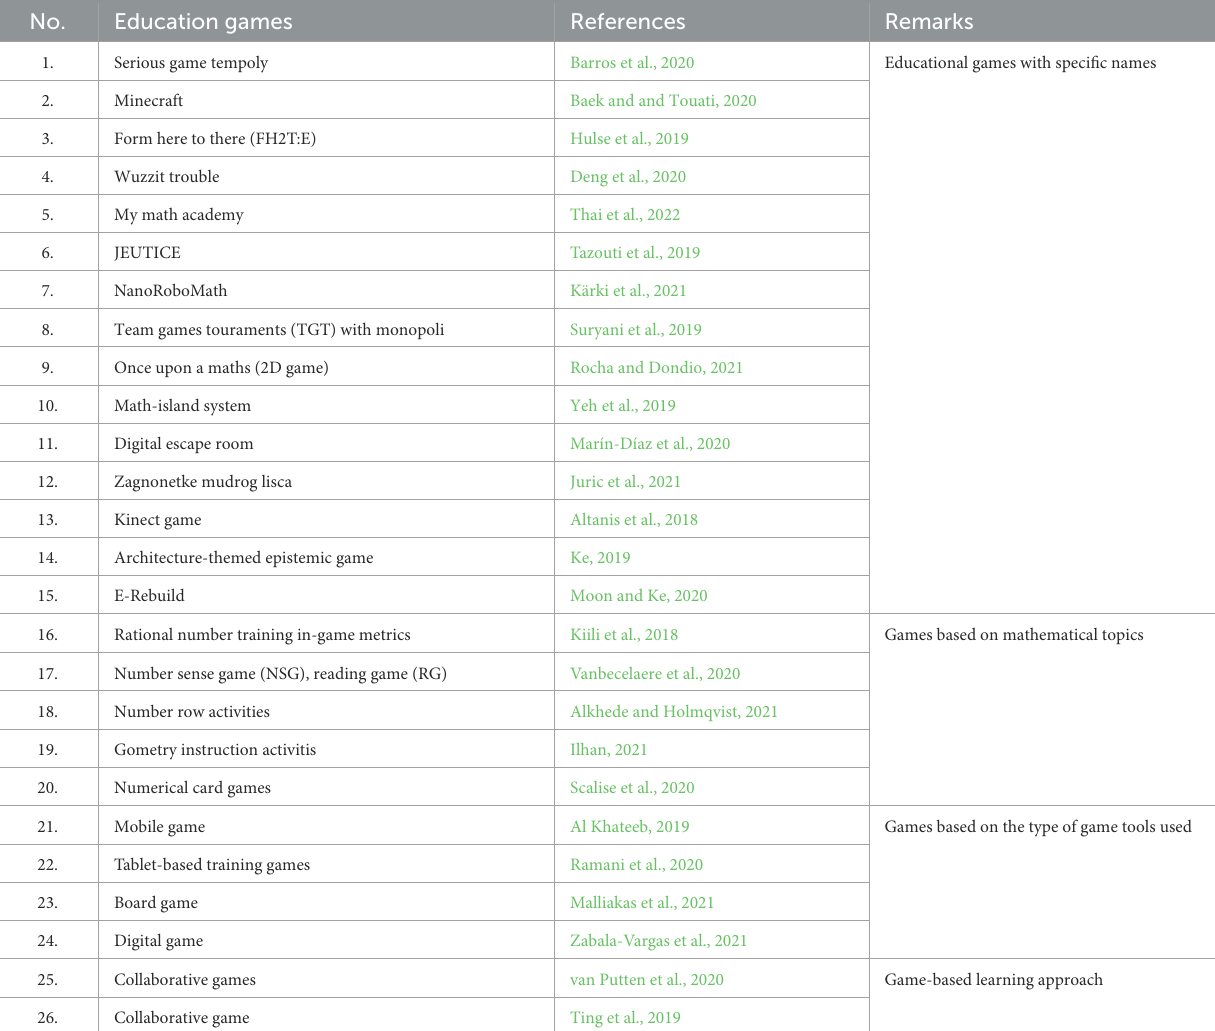
TABLE 4 Analysis of the previous studies regarding the application or game tools